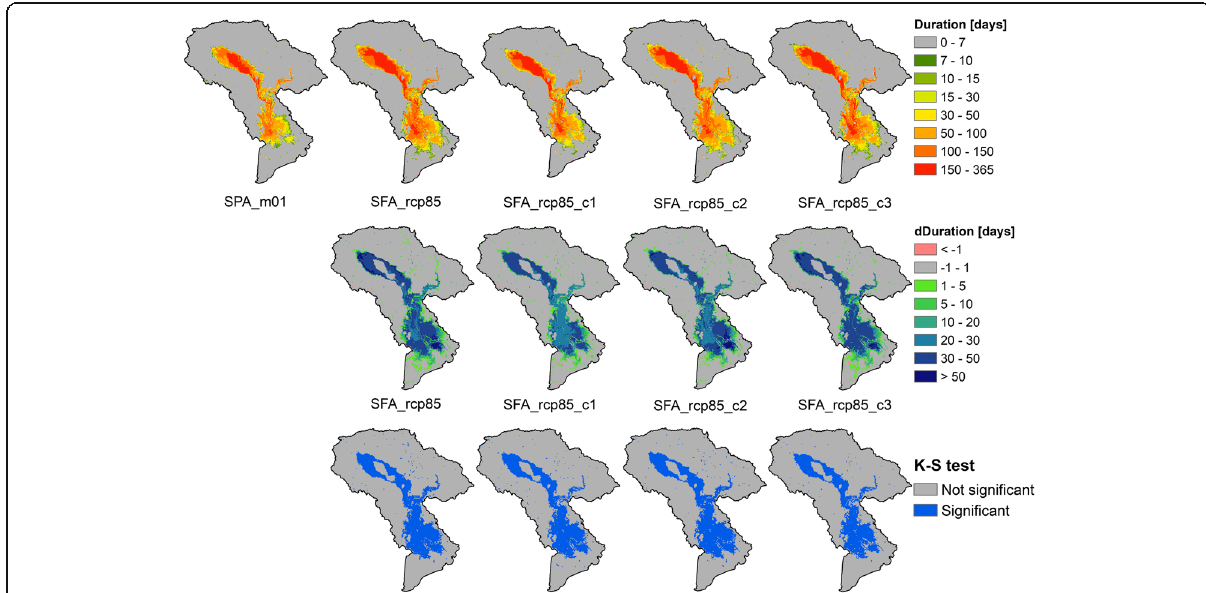
Fig. 12 Spatial distribution of inundation duration (upper row), difference between present and future SST scenarios (middle row), and K-S test (lower row) for MRI-AGCM3.2S model